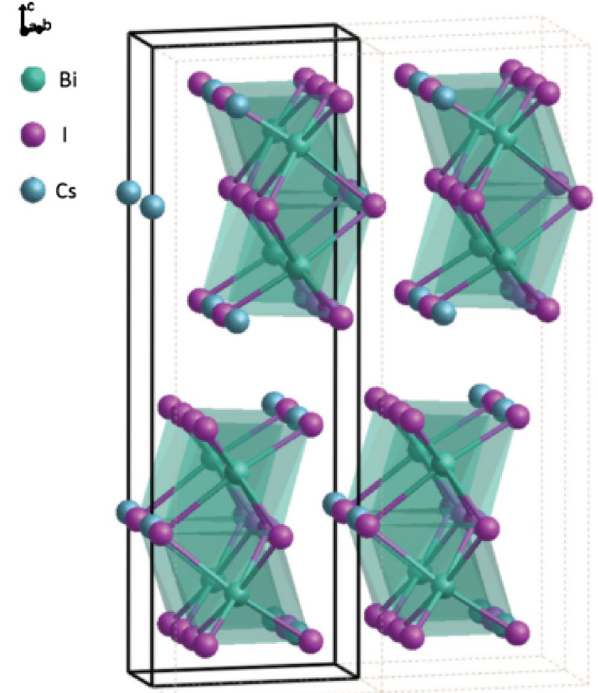
Fig. 5 Schematic diagram of Bi-based perovskite (Cs